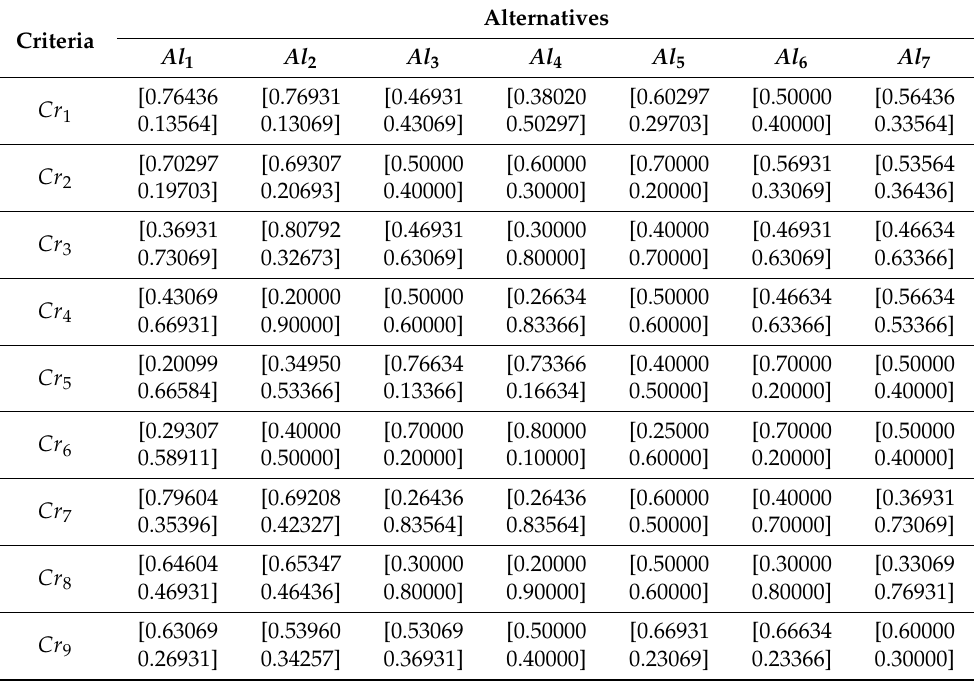
Table 5. Normalized decision matrix.